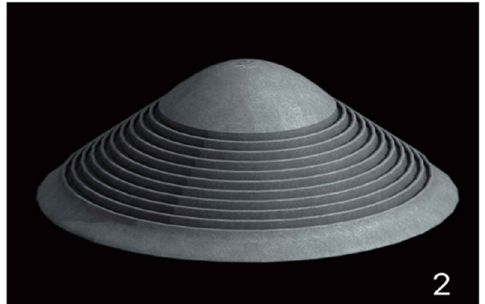
Figure 2. Initial scheme indication of interception system (retaining mode).